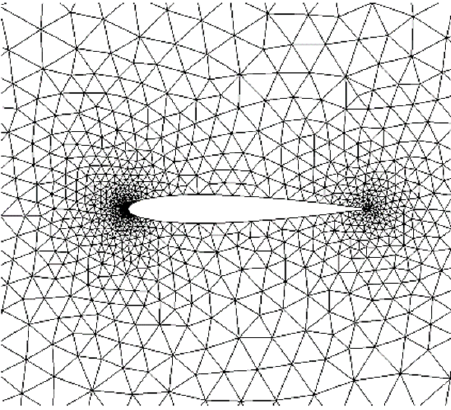
Figure 4. Computational mesh around NACA0012 airfoil.